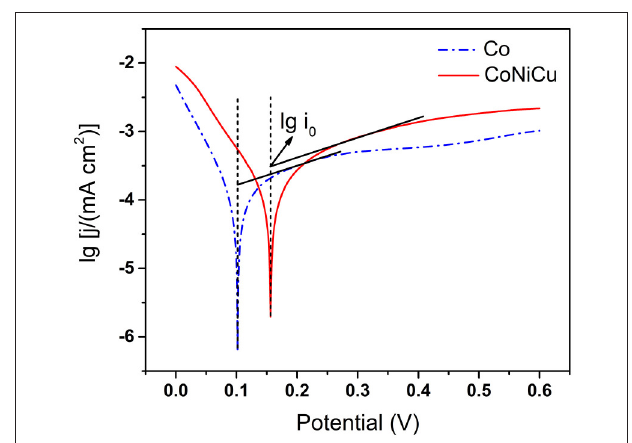
FIGURE 7 | Tafel plots of Co and CoNiCu electrodes in 0.1M NaOH + 0.3mM